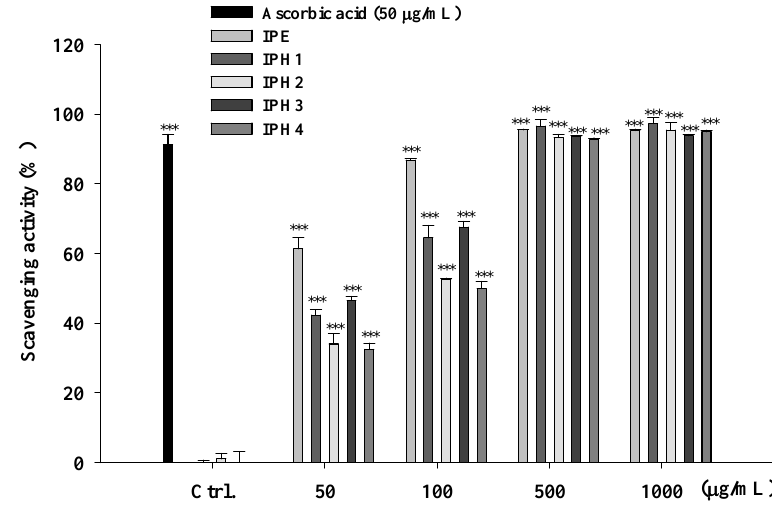
Figure 3. DPPH radical scavenging activity of IPE and its hydrolysates. (n = 4; *** , P < 0.001).